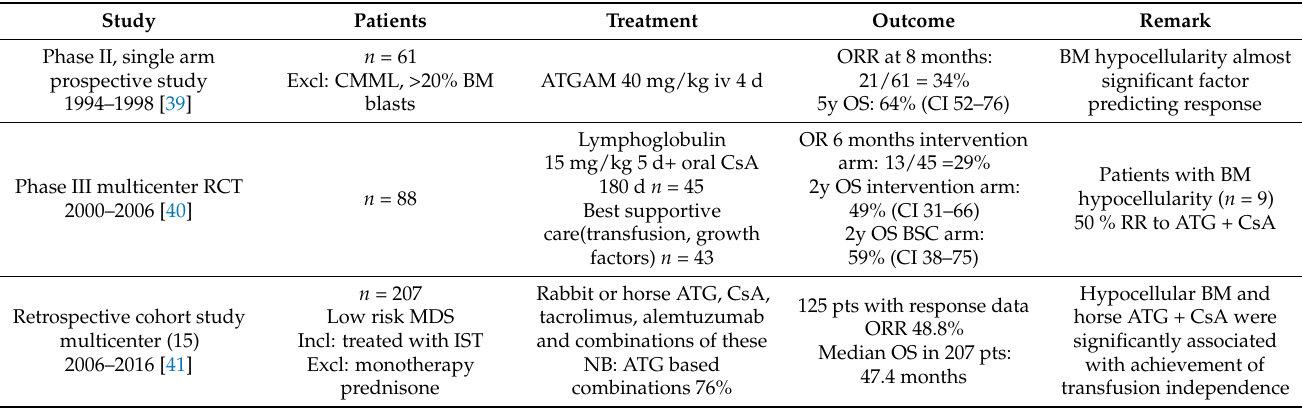
Table 5. Published studies on ATG as treatment in MDS. d: days, y: year, ORR: overall response rate, CR: complete remission.